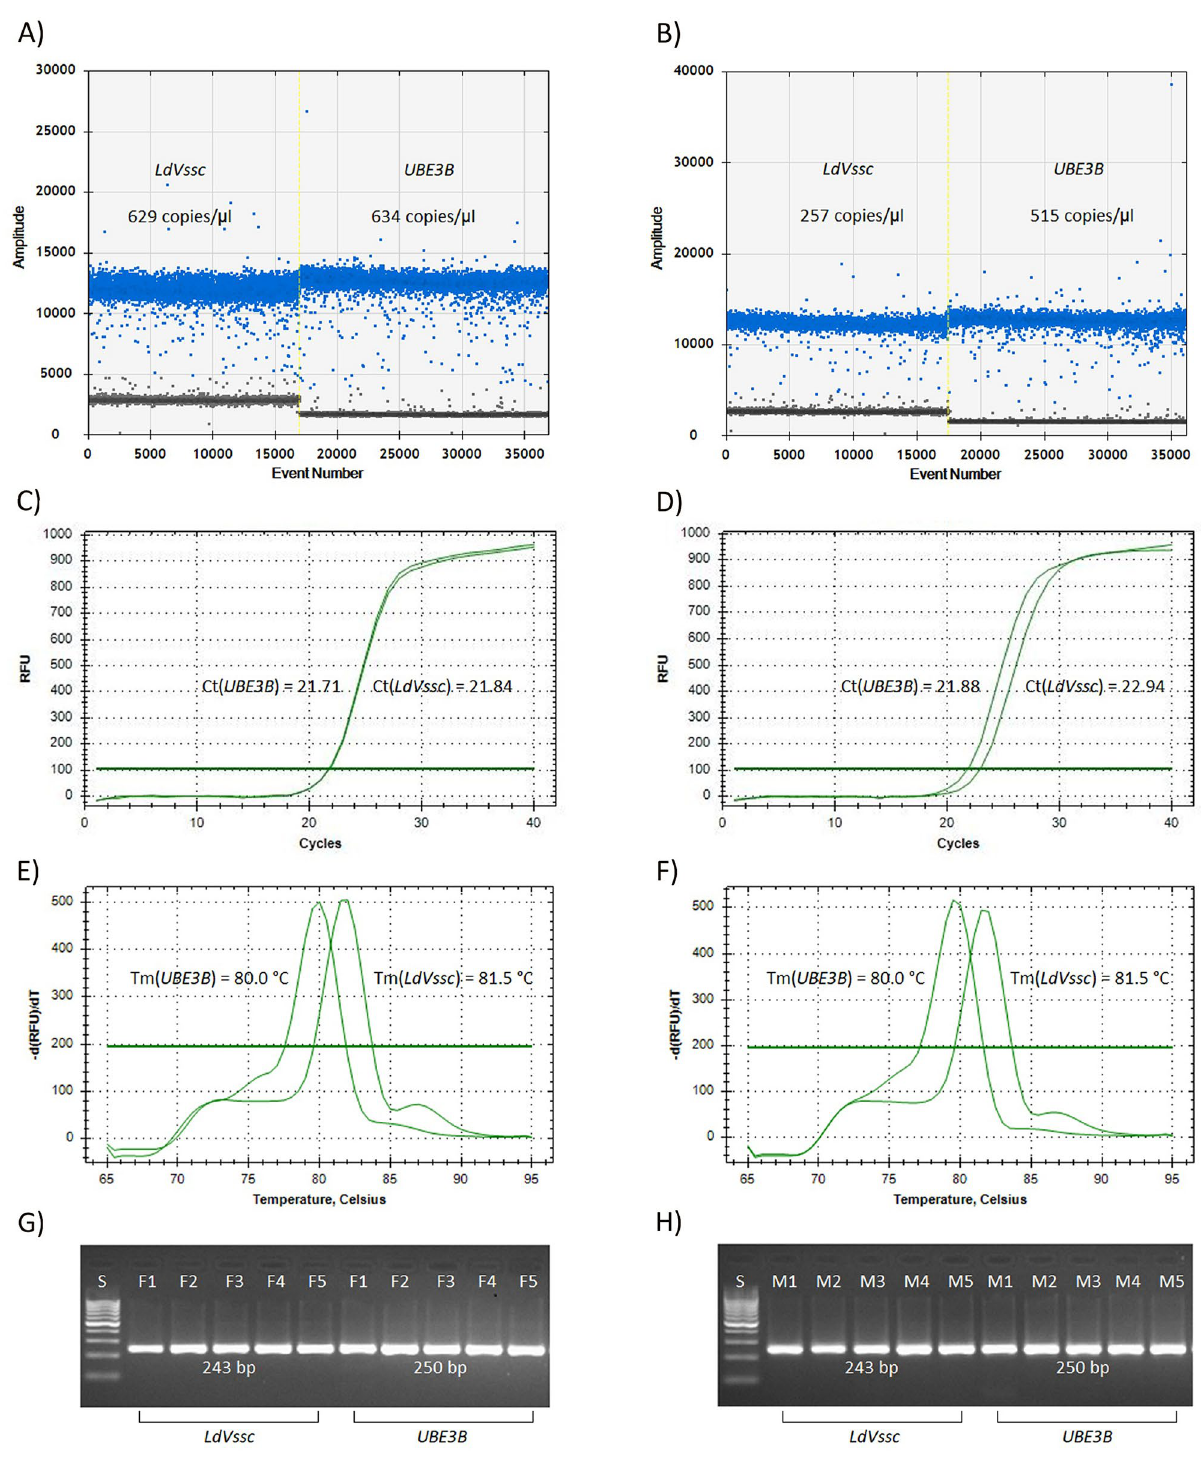
Figure 1. Outputs of ddPCR and qPCR of CNV based sex detection using markers LdVssc and LdUBE3B typically detected in female (left side) and male (right side). Counts of positive and negative droplets ( A , B ), qPCR Ct values ( C , D ), qPCR melting analysis ( E , F ), and electrophoretograms of LdVssc and LdUBE3B amplicons ( G , H